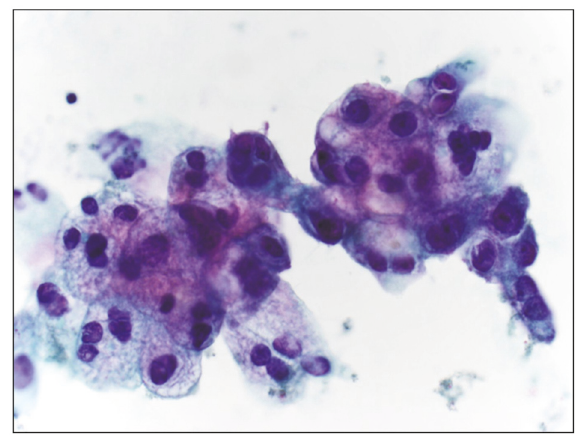
Figure 2: Endoscopic ultrasound (EUS) fine needle biopsy of pancreas revealed adenocarcinoma with mucinous